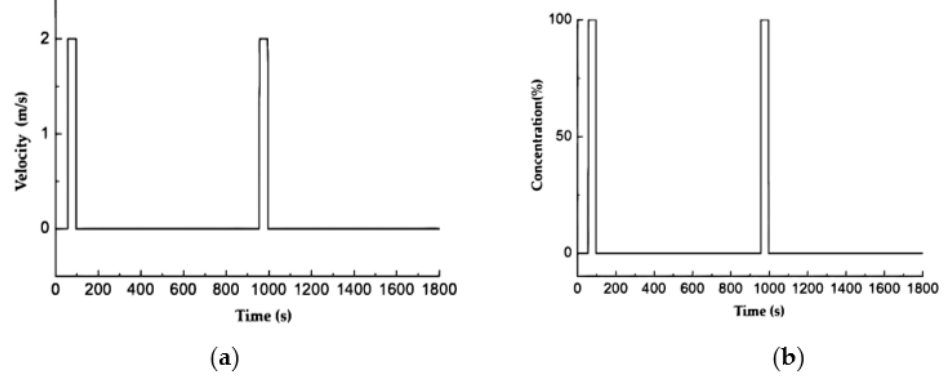
Figure 8. Schematic diagram of boundary condition change of No. 1 oil fume pan: ( a ) Regularity of the release rate of oil smoke with time; ( b ) Variation law of oil smoke concentration with time. No. 2 boiler was closed and had no oil smoke. It is treated as adiabatic condition. The